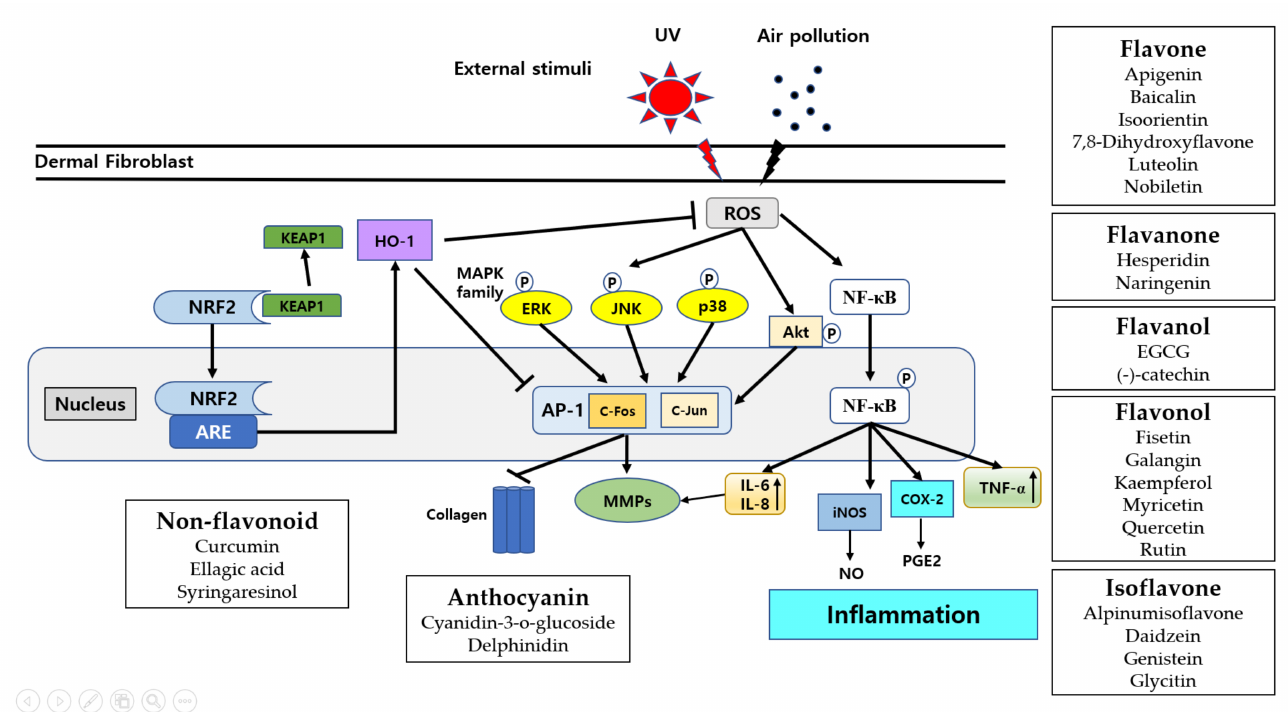
Figure 1. Diagram of several molecular mechanisms in skin dermis exposed to external stimuli. External stimuli such as UV radiation or air pollutants can cause direct damage to the DNA and pro- duce ROS. These can further stimulate many inflammatory responses and the MAPK family, which can lead to photoaging through inflammation and collagen degradation. The KEAP1-NRF2 stress response pathway is the principal inducible defense against oxidative stresses. Under homeostatic conditions, KEAP1 regulates the activity of NRF2. In response to stress, an intricate molecular mecha- nism facilitated by sensor cysteines within KEAP1 allows NRF2 to escape ubiquitination, accumulate within the cell, and translocate to the nucleus, where it can promote its antioxidant transcription program. In the diagram, polyphenol chemicals in each box are organized into the